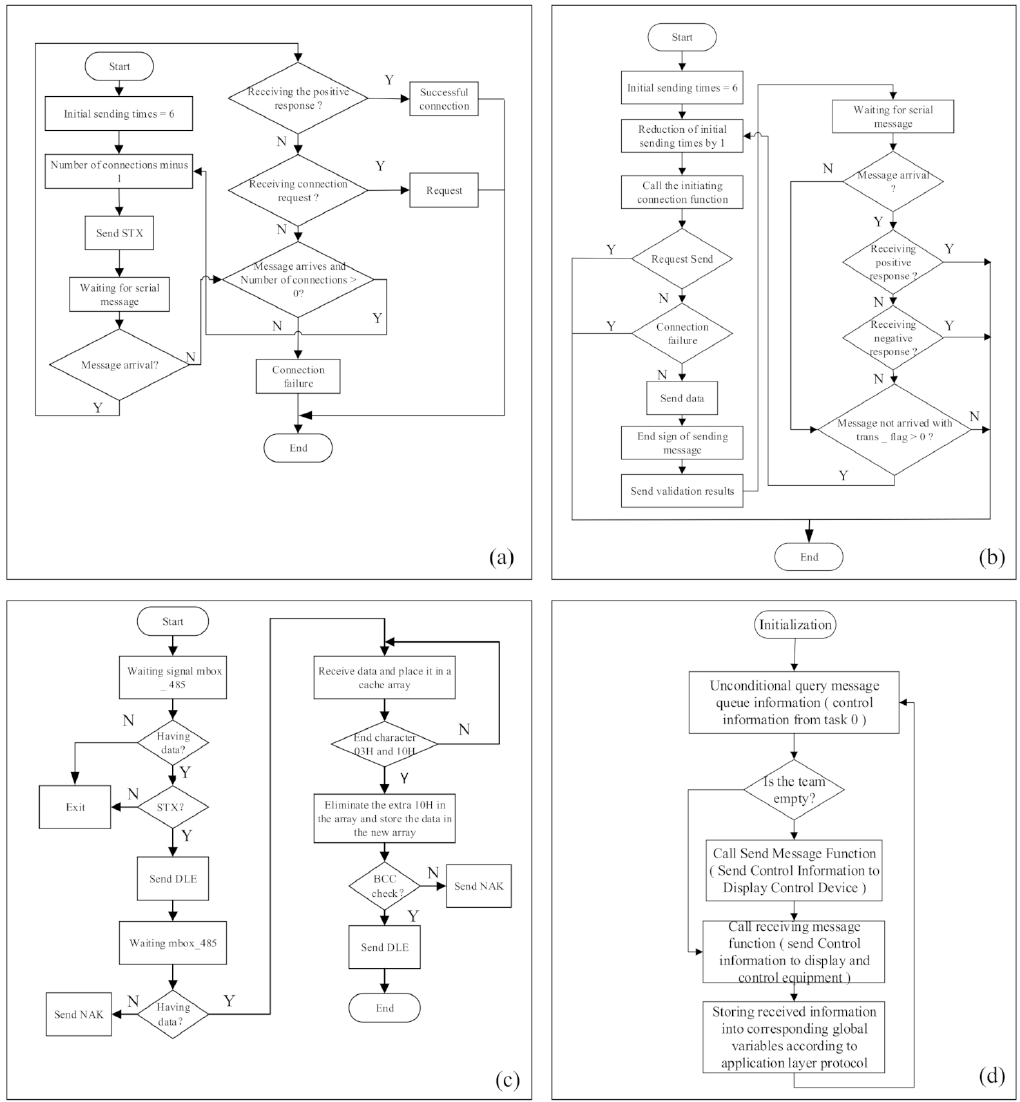
Figure 8. Flowchart of task execution: ( a ) initiating connection flowchart, ( b ) partial flowchart of sending message function, ( c ) partial flowchart of receiving message function, and ( d ) flowchart of Tasks 4 and 5.